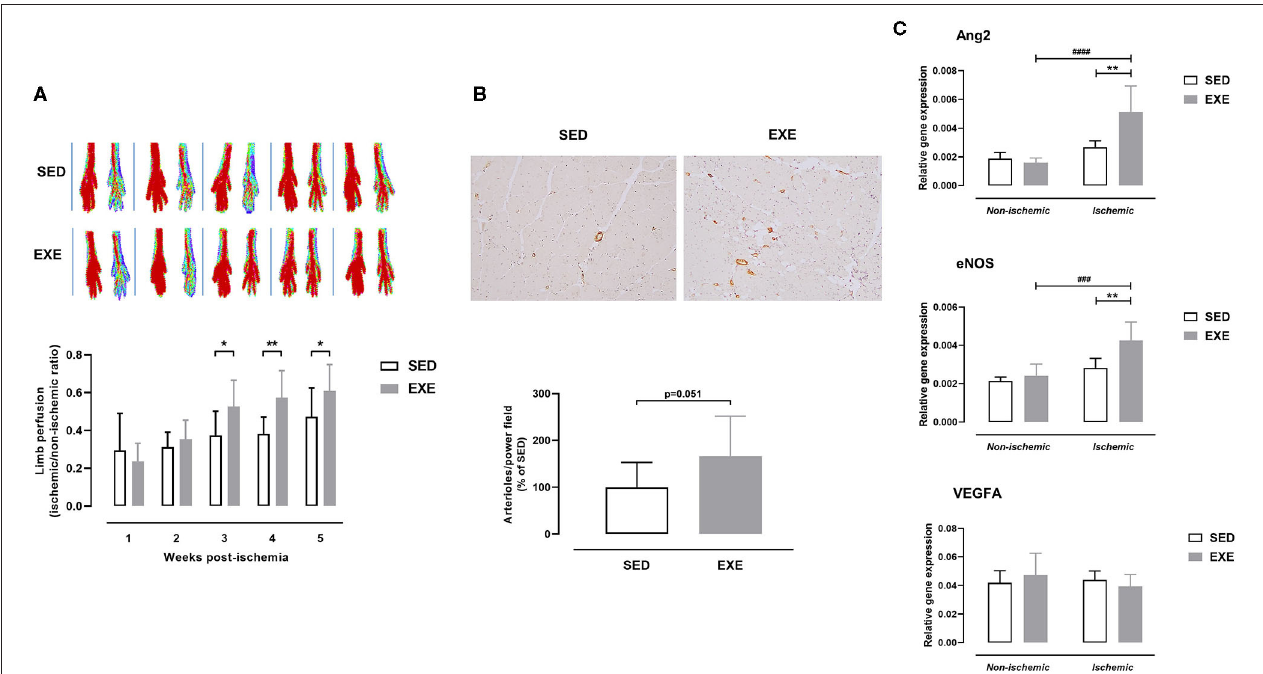
FIGURE 3 | Effect of preventive exercise on ischemic hindlimb perfusion in ApoE − / − mice with PAD. (A) Top: Representative laser Doppler images of ischemic (right) and contralateral non-ischemic (left) paws from week 1 to week 5 post-ischemia. Bottom: Ratio of perfusion in the ischemic hindlimb to the non-ischemic hindlimb ( n = 11 animals per group). (B) Top, Representative images of ischemic gastrocnemius cross-sections immunostained with anti- α -SMA (in brown) at × 10 high-power field. Bottom: Quantification of arterioles number per high power field at week 5 post-ischemia ( n = 10 animals per group). Data are expressed as the percentage of the mean value in SED. (C) Gene expression analysis by real-time RT-PCR of key genes involved in arteriogenesis (Ang2, eNOS, and VEGFA) in non-ischemic and ischemic gastrocnemius muscle of SED and EXE mice at week 5 post-ischemia ( n = 5 animals per group). Unpaired t -test in (A) and (B) : * p < 0.05, ** p < 0.01 vs. SED. Two-way ANOVA with Sidak’s multiple comparisons test in (C) : ### p < 0.001, #### p < 0.0001 vs. respective non-ischemic; ** p < 0.01 vs. SED. Bar graphs represent mean ±